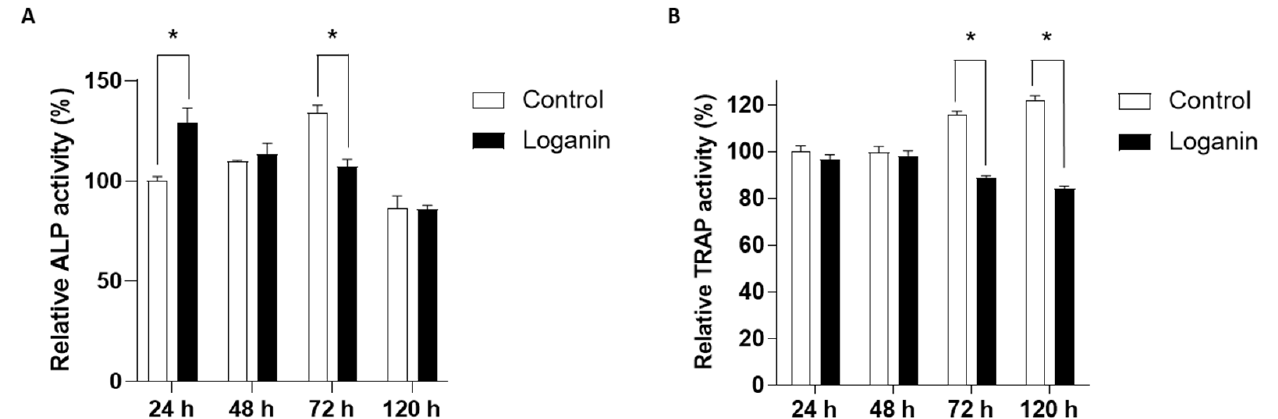
Figure 5. Effects of loganin on osteoblast–osteoclast differentiation in a co-culture system. MC3T3-E1 cells co-cultured with bone marrow monocytes were incubated with loganin (10 µ M) for the indicated time periods (24, 48, 72, and 120 h) and the relative ( A ) ALP activity and ( B ) TRAP activity were evaluated. * p < 0.05 vs. control (Student’s t -test).